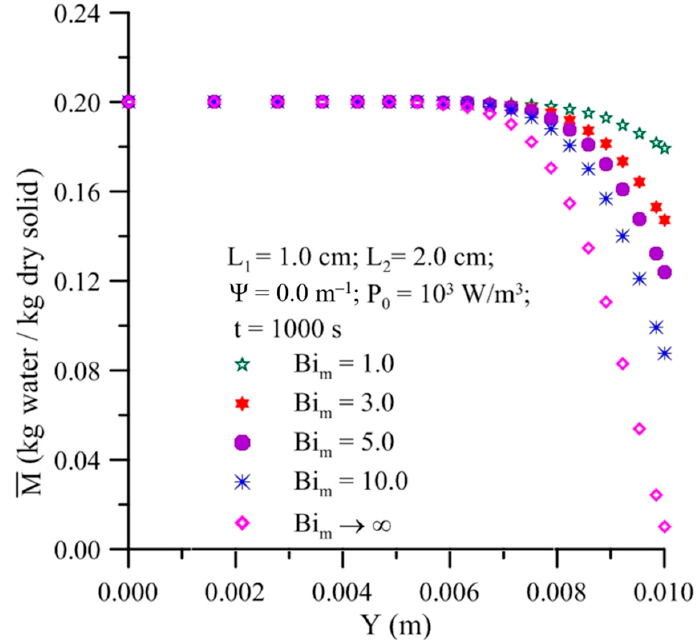
Figure 7. Transient behavior of the average temperature in a prolate spheroidal solid with aspect ratio 2.0, different heat transfer Biot numbers and fixed microwave power density.